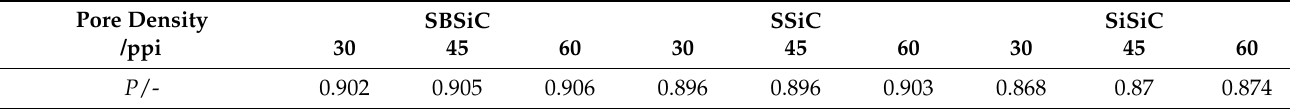
(SSiC)—have been selected for the study. Two cylindrical samples (diameter = 54.2 mm and height = 70 mm) per linear pore densities of 30 ppi (pores per inch), 45 ppi and 60 ppi with porosities P between 86.8% and 90.6% (see Table 1, reporting average porosity of each pore density samples) were manufactured (IKTS Fraunhofer, Germany). Table 1. Porosity of applied SiC-based open-cell